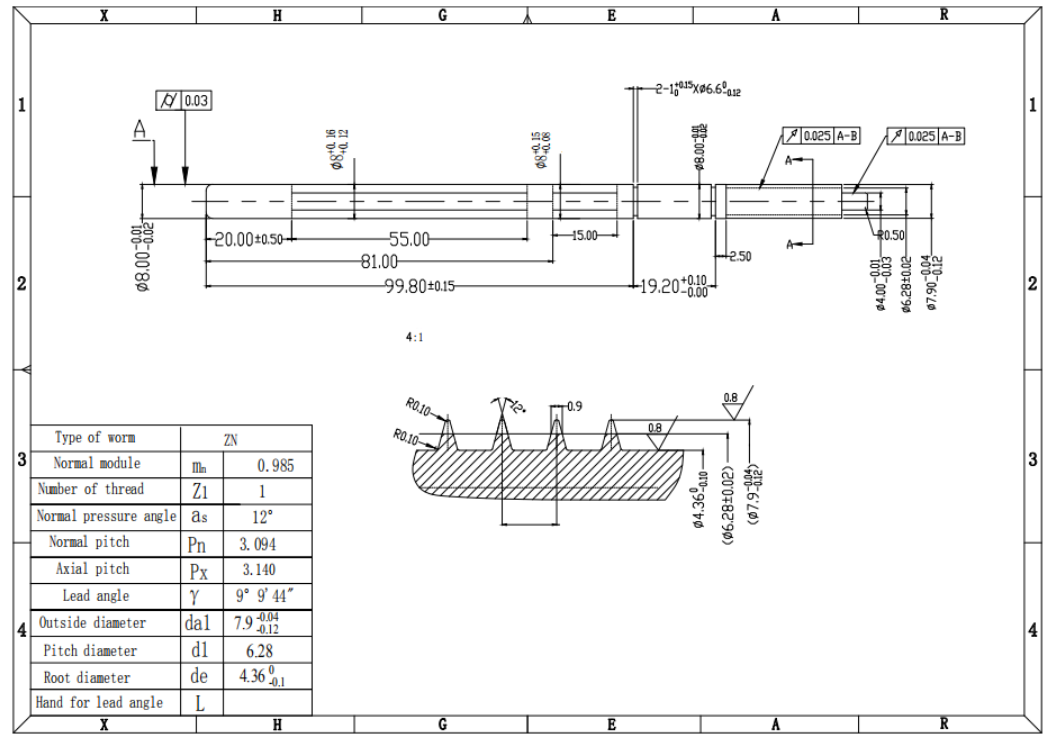
Figure 17. Engineering drawing for the worm.